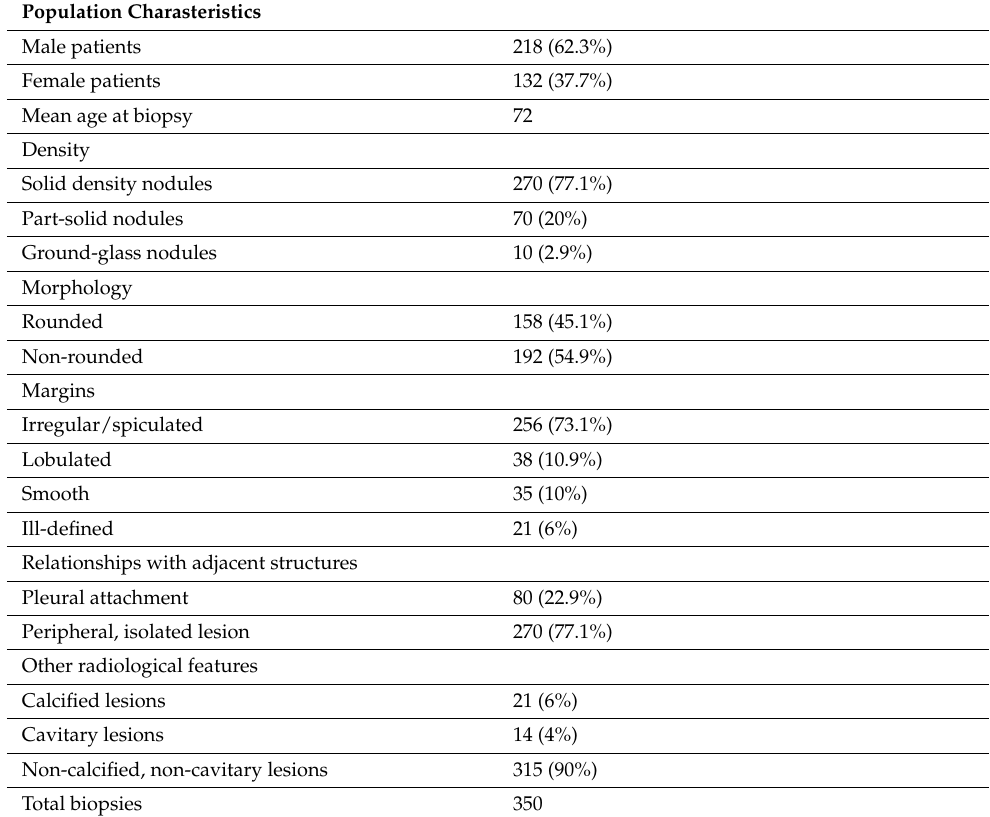
Table 2. Population characteristics and radiological features of the